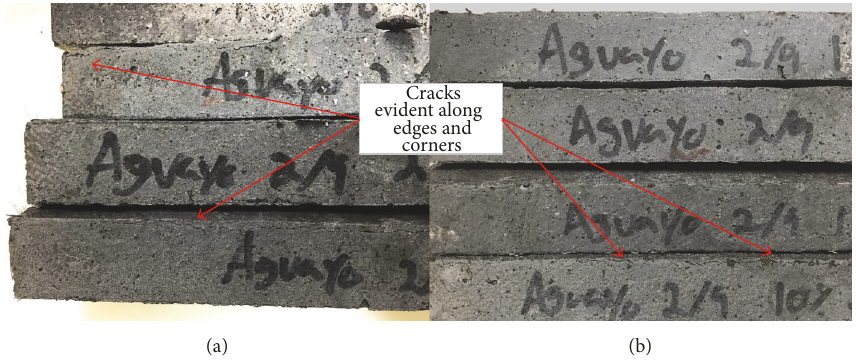
Figure 5: Cracking of reactive bars observed after 28 days in NaOH solution: (a) RA-30FS; (b) RA-10FS.